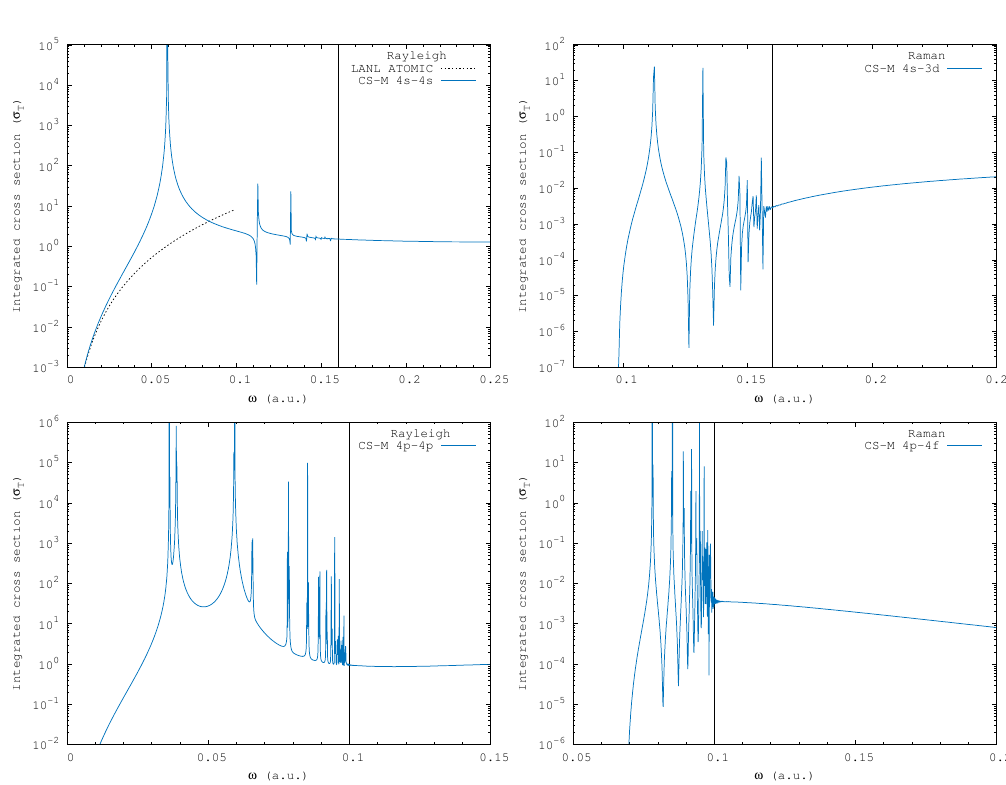
Figure 7. Same as Figure 5 but for